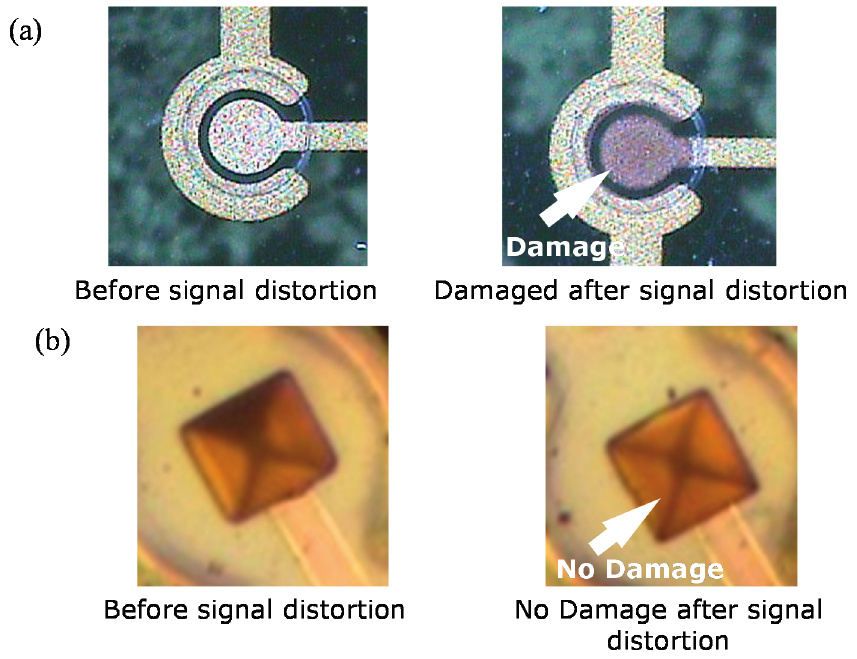
Figure 5. Microscopic image of microelectrode before and after signal distortion. ( a ) 2D Au microelectrode; ( b ) 3D Au